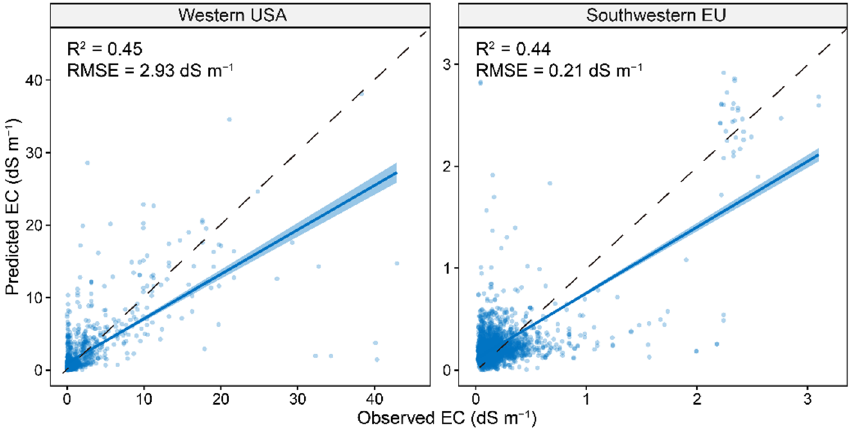
Figure 8. Scatter plots of predictive models with model performance at two areas for regional validation. The solid line is a fitted line for each model, whereas the dashed line is the 1:1 line.